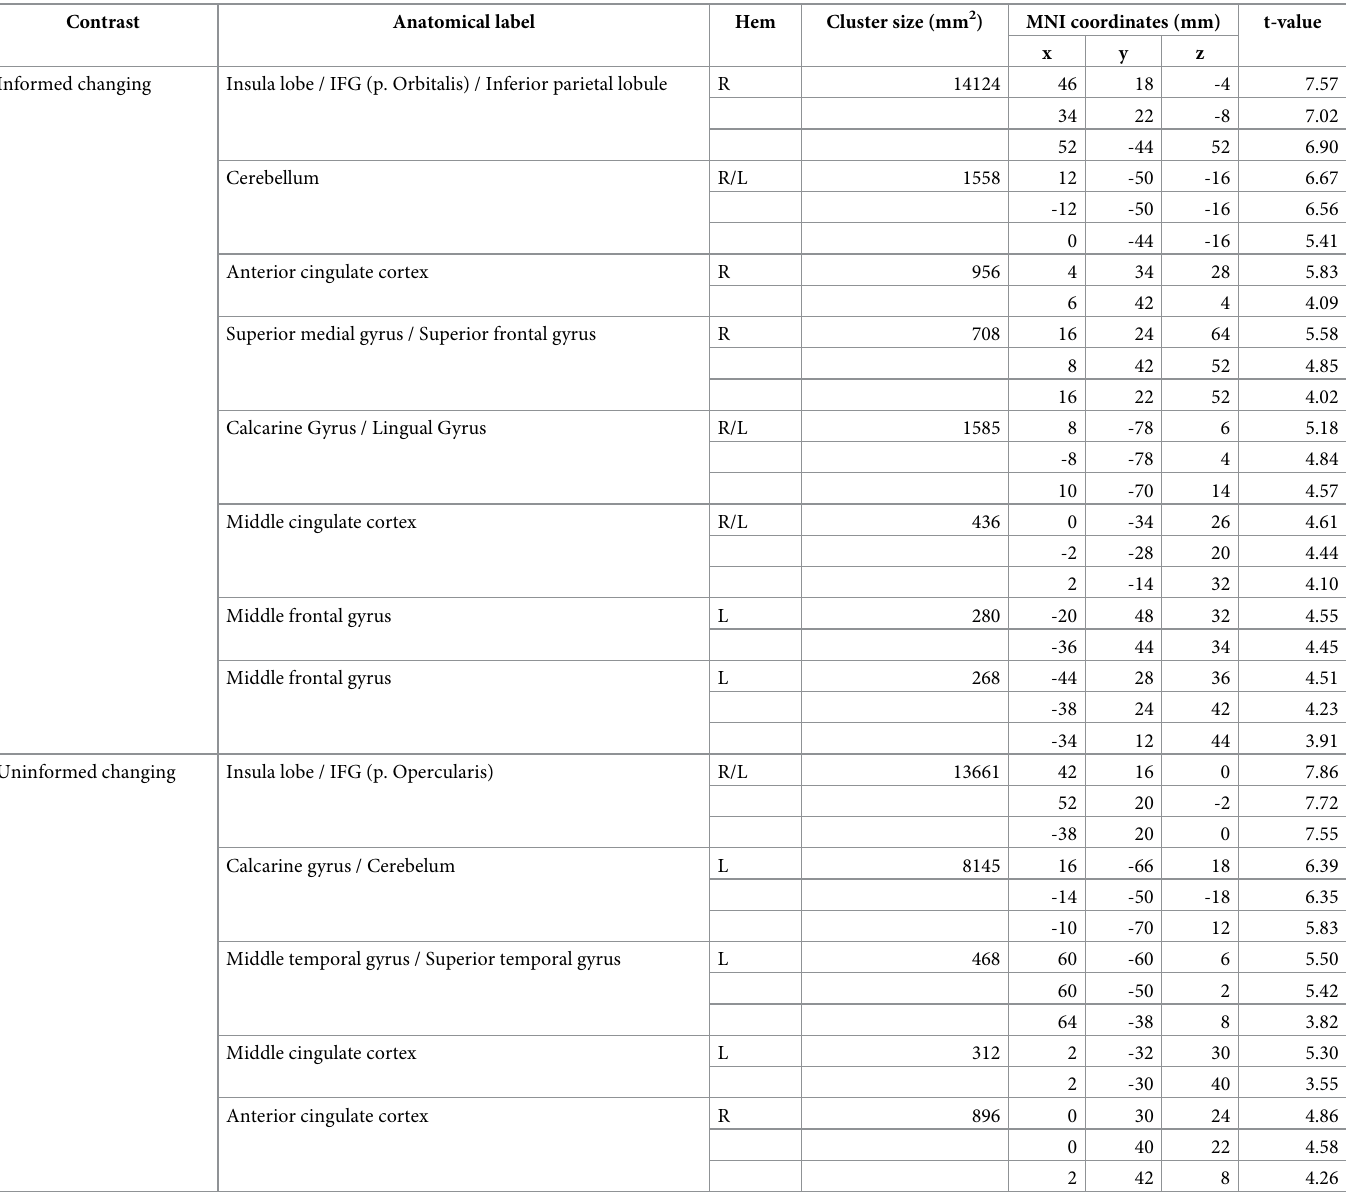
Table 2. Brain regions showing signal increases during the change process.